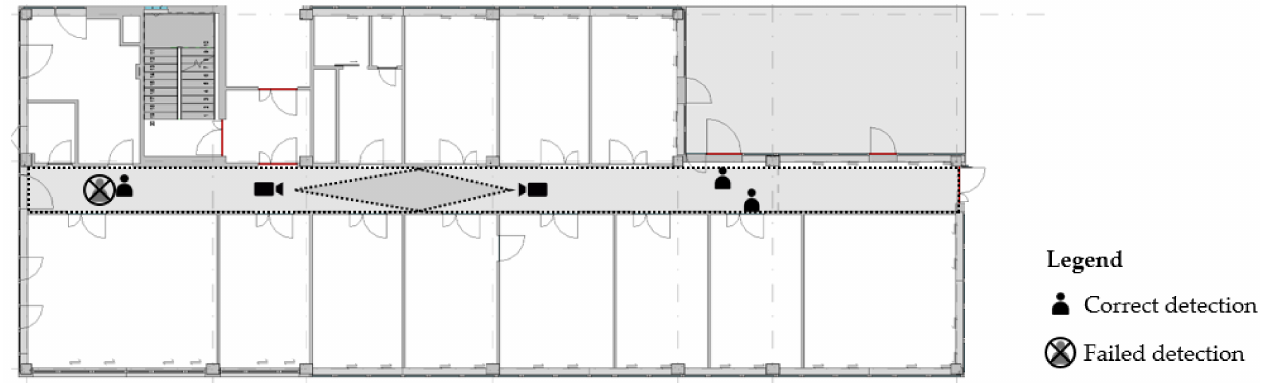
Figure 10. Location and orientation of camera-based sensors in